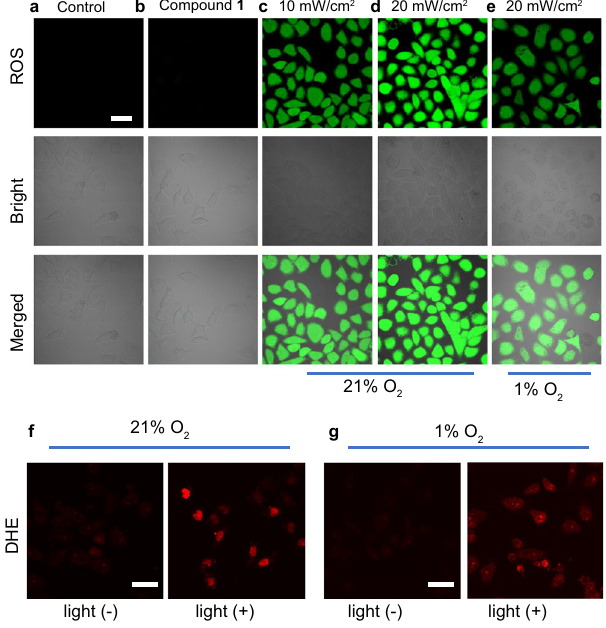
Fig. 5 In vitro ROS generation of compound 1. CLSM images of MCF-7 cells stained with DCFH-DA ( a ), compound 1 (10 μ M) ( b ), and DCFH- DA + compound 1 with different light doses under ( c , d ) normoxic (21% O 2 ) and ( e ) hypoxic (1% O 2 ) conditions. Ex: 488 nm, Em: 500 – 550 nm. Scale bar: 30 μ m. CLSM images of MCF-7 cells stained with compound 1 (10 μ M) under normoxic (21% O 2 , f ) and hypoxic (1% O 2 , g ) conditions using DHE as the intracellular O 2 − • fl uorescence indicator before and after white-light irradiation ( “ + ” represents with irradiation, “ − ” represents without irradiation, white light 20 mW/cm 2 , 10 min). Ex: 488 nm, Em: 590 – 630 nm. Scale bar: 30 μ m. Each experiment was repeated three times independently, with similar